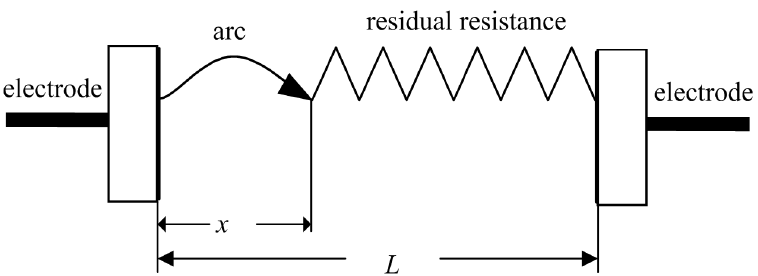
Figure 1. Circuit flashover